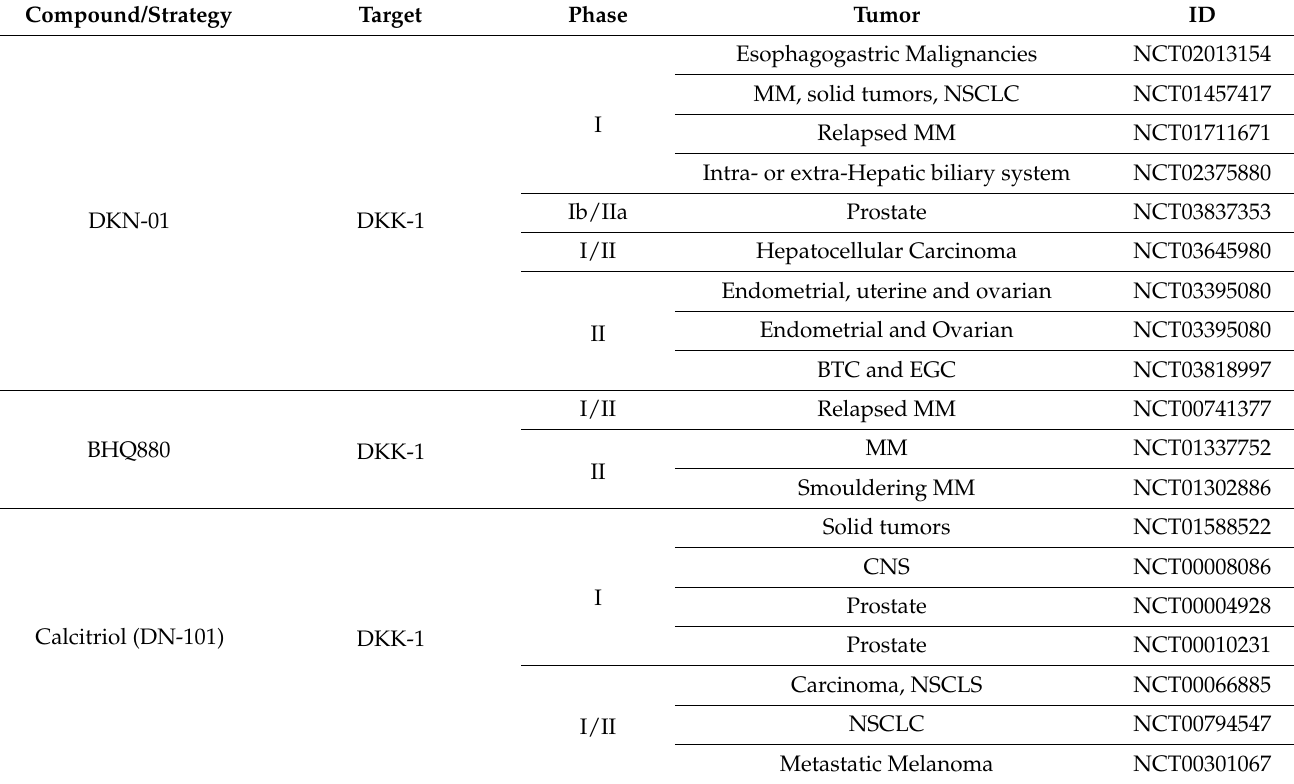
Table 3. Status of clinical trials targeting DKK proteins in cancer 1